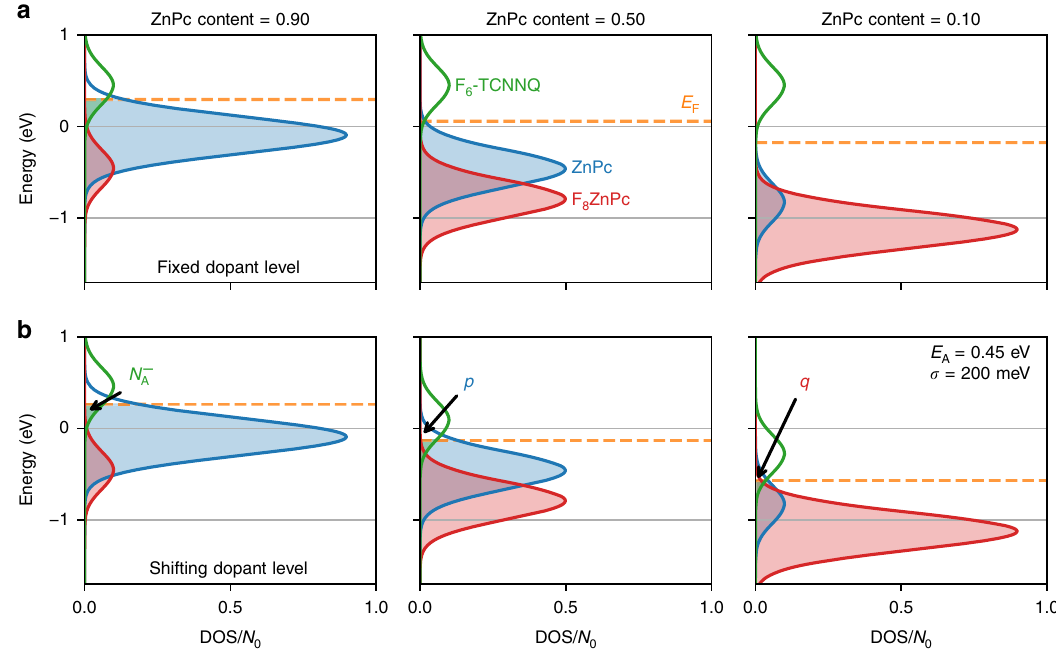
Fig. 3 Density of states for the statistical model. The density of states (DOS) for the two cases of distributions: a with the dopant level at fi xed energy and b with a dopant level shifting in energy, for molar ratios 9:1, 1:1, 1:9 of ZnPc:F 8 ZnPc (left to right). The Fermi level E a dashed orange line. Below the Fermi level, the dopants are ionised ( fi lled green colour) and the host states are full ( fi lled blue and red). The model parameters are reported inset in the bottom right panel, and are varied in the analysis